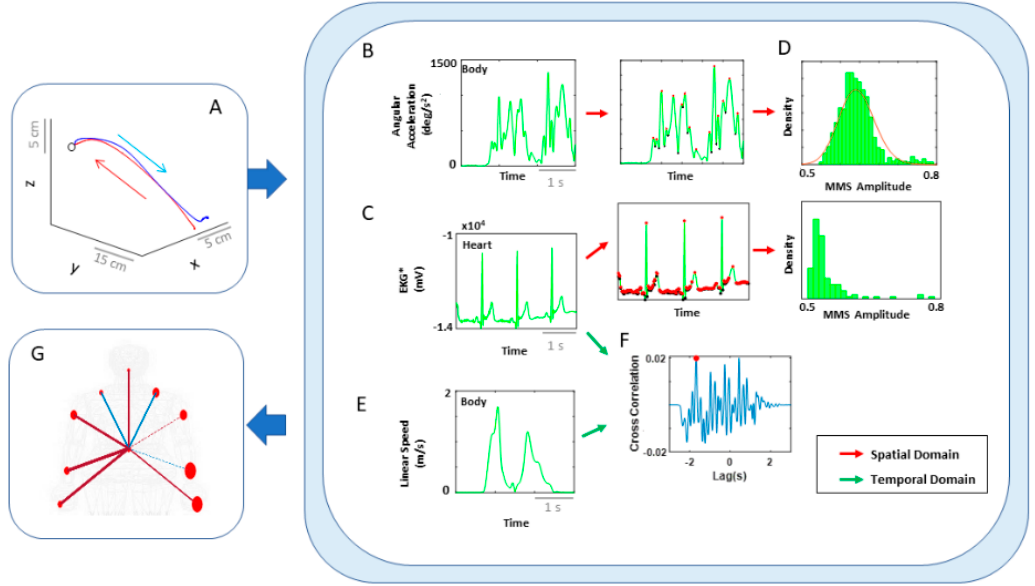
Figure 5. Analytical pipeline and visualization methods for the kinematics-heart network. ( A ) Typical movement trajectory of the performing hand position, while performing a single pointing action towards a target. Each trajectory was separated into forward–deliberate (red) and backward–spontaneous segments (blue) according to hand–target updated distance and near-zero-speed value (see Figure A2 for details). ( B )Angularaccelerationtimeseriesofthehandduringatypicalpointingtask. MMSamplitudes from the angular acceleration time series were extracted for each body part. ( C ) Filtered EKG time series during a pointing task. MMS amplitudes from the filtered EKG time series were extracted. ( D ) Histograms of compiled MMS amplitudes. For spatial analysis, pairwise EMD was computed betweenhistogramsfromeachbodypartandheartactivity. ( E )Linearspeedtimeseriesoftheperforming hand. For temporal analysis, linear speed kinematics time series was used. ( F ) Cross-correlation between a single body part’s linear speed and filtered EKG signal. For each trial, cross-correlation was computed between a pair of filtered EKG and a single body part’s linear speed time series, and the maximal value (red dot) and its corresponding lag values were extracted. ( G ) Visualization of connectivity. Network connectivity was visualized, where node size represented the EMD between the corresponding pair of body part and heart signals (i.e., spatial metric), and edge thickness represented the median cross-correlation values between the signal pairs (i.e., temporal metric). The edge colors were visualized, such that red would indicate EKG signals temporally leading linear speed signals, and blue would indicate linear speed leading EKG signals.